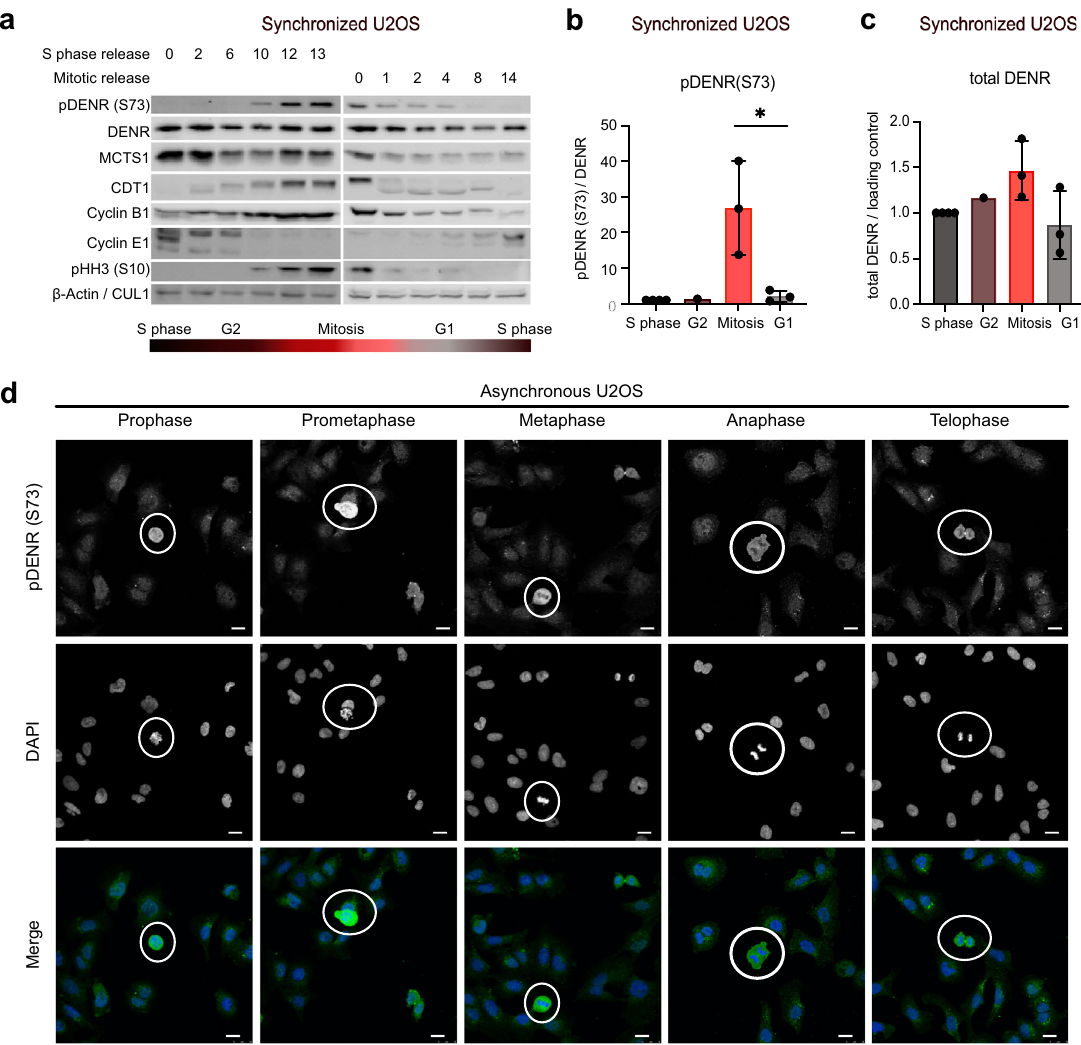
Fig. 1 DENR protein is phosphorylated at Ser73 during mitosis. a U2OS cells were synchronized in S phase using a double thymidine block or in mitosis using sequential thymidine and nocodazole treatment, then released, and collected at the indicated time points and subjected to immunoblotting. b – c Quanti fi cation of Western Blot experiments as described in a shows exclusive DENR (S73) phosphorylation and mild accumulation of total DENR protein in mitosis. Means of n = 1 (G2, dark-red) or n = 3 (S phase, dark-gray, mitosis, light-red, G1, light-gray) independent biological replicates are shown; unpaired t -test was performed with * p (mitosis v. G1) = 0.03, error bars indicate standard deviations. d Asynchronous U2OS cells immunostained using pDENR (S73) antibody show phosphorylation predominantly in early phases of mitosis (prophase, prometaphase, metaphase). Cells in the mitotic phases indicated above the respective images are encircled. Representative images from n = 3 independent biological replicates are shown. Scale bars indicate 10 µ